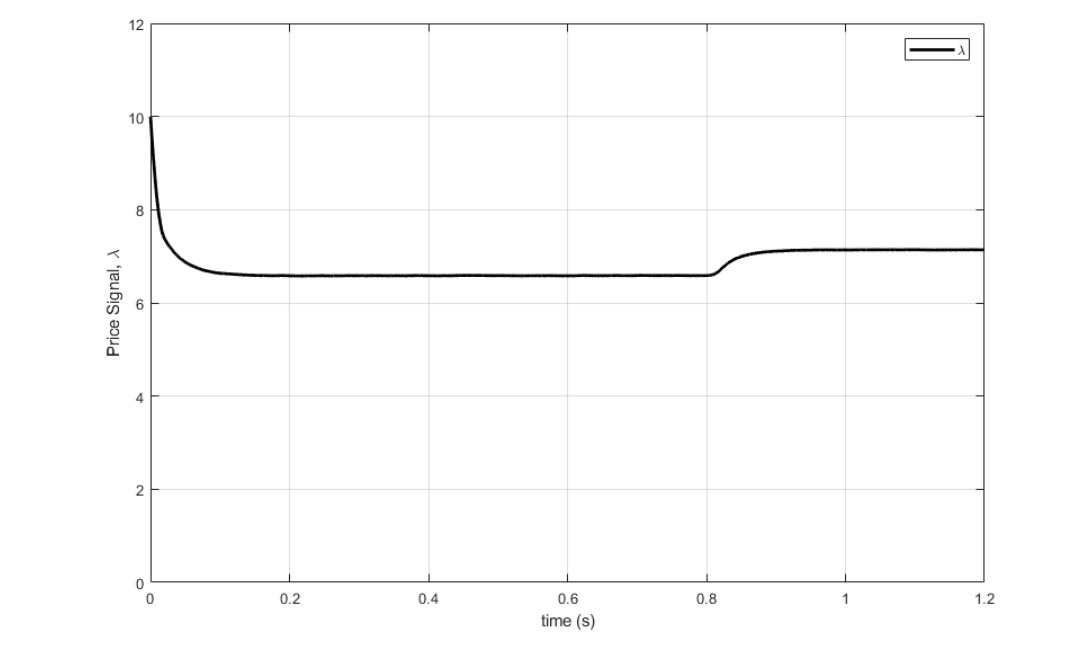
Figure 6. Price dynamics